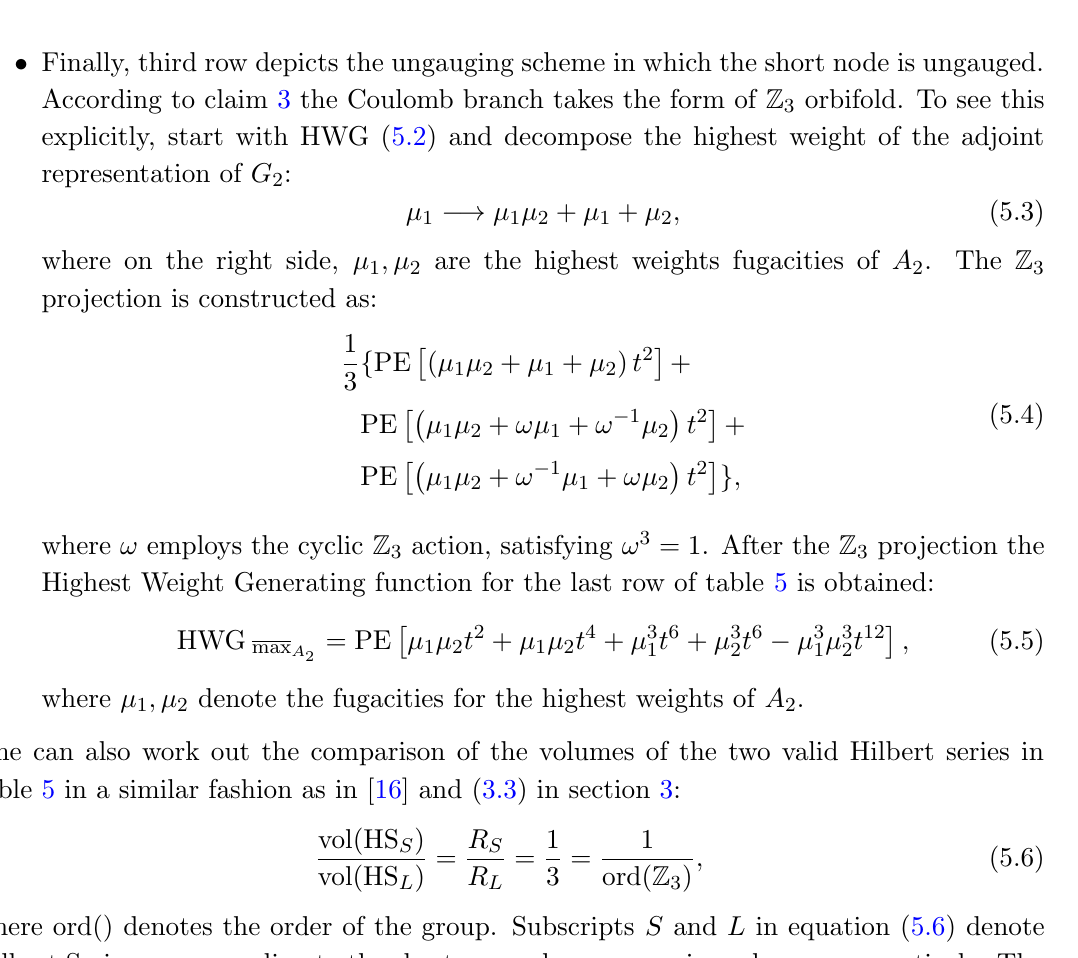
Table 5 . Ungauging schemes for the a(cid:14)ne G 2